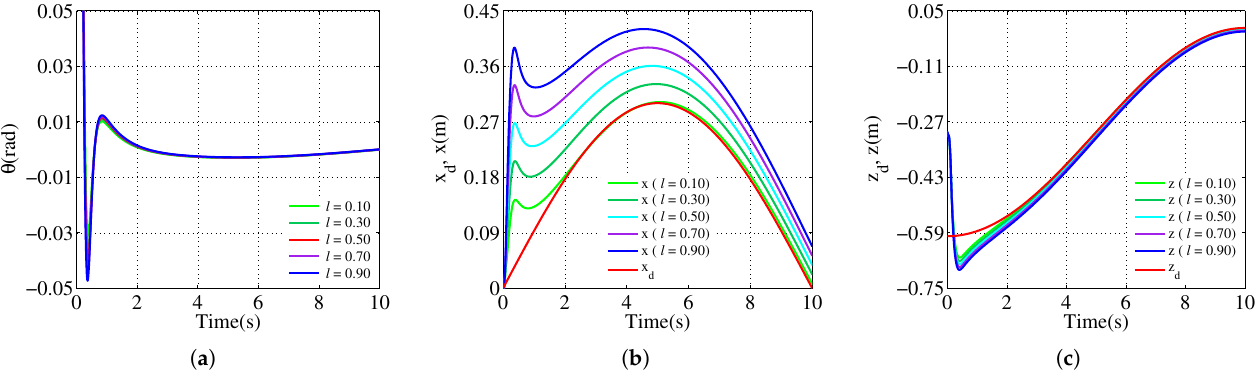
Figure 11. The simulation tests when l = 0.10,0.30,0.50,0.70, and 0.90. ( a ) The θ ; ( b ) the x d and x ; and ( c ) the z d and z